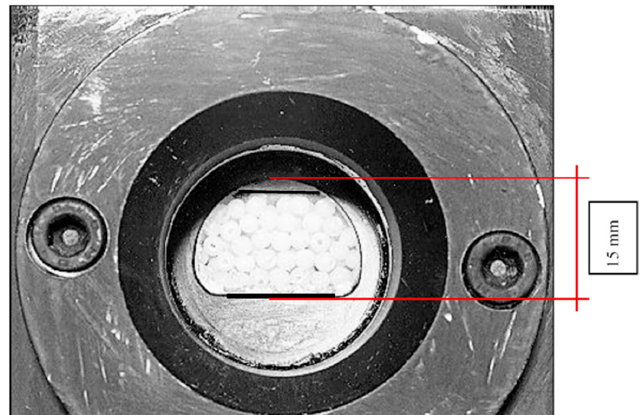
Figure 2. Window mounted on the external wall of the channel; the height of the window is 15 mm (courtesy Schippa and Lamberti, [30]).